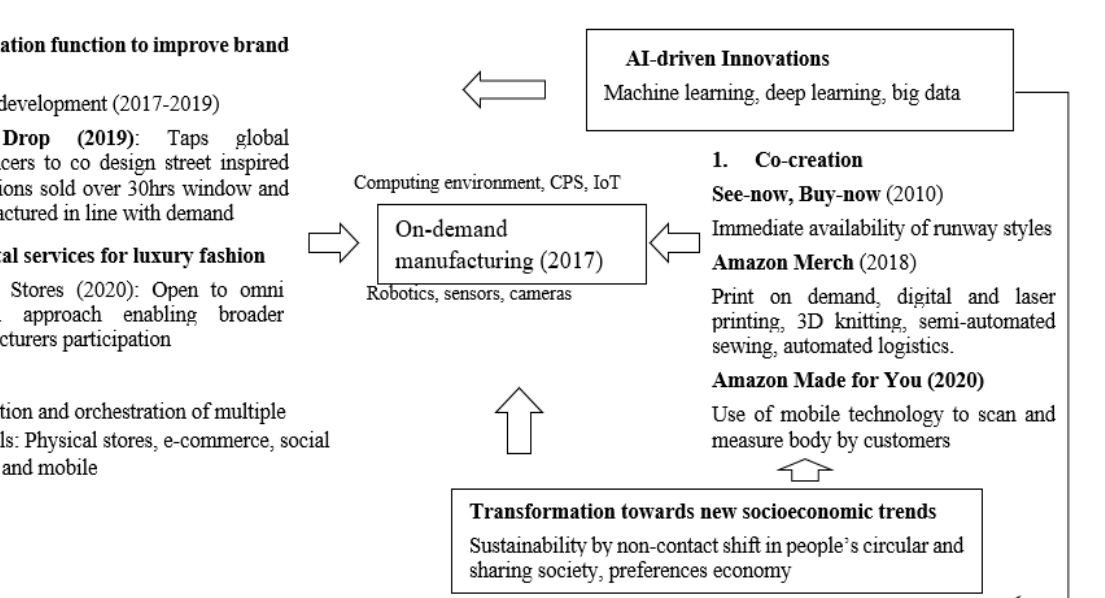
Figure 13. Amazon’s initiatives toward on-demand manufacturing in the luxury fashion business.